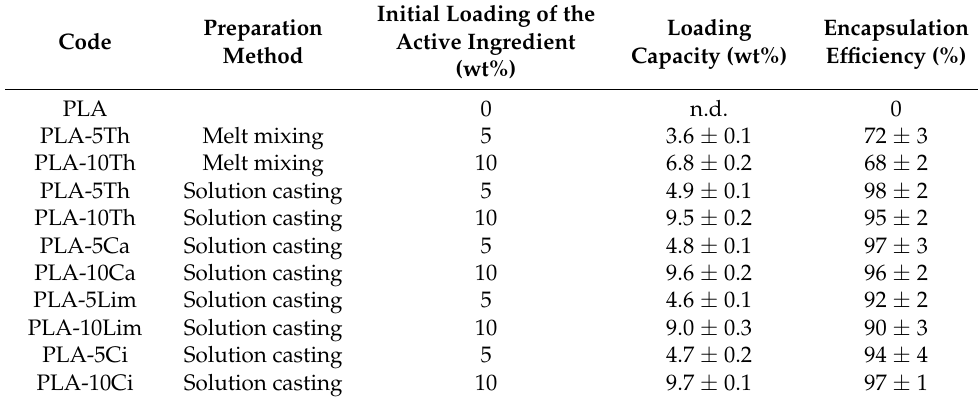
Table 2. Quantification of the active ingredients in the PLA matrix.